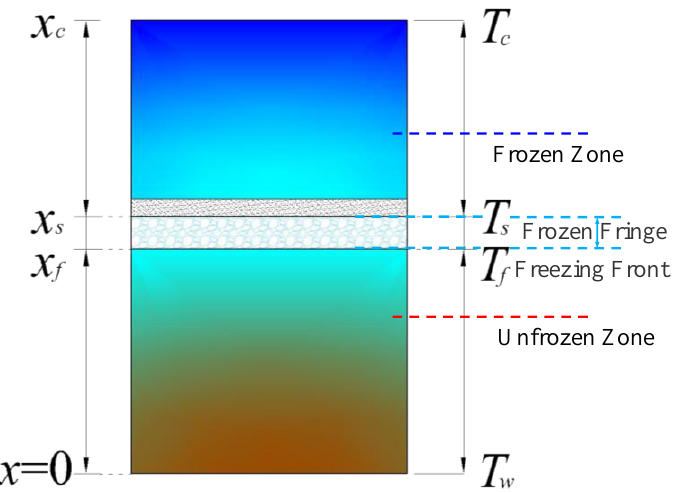
Figure 1. Schematic diagram of frozen fringe theory.